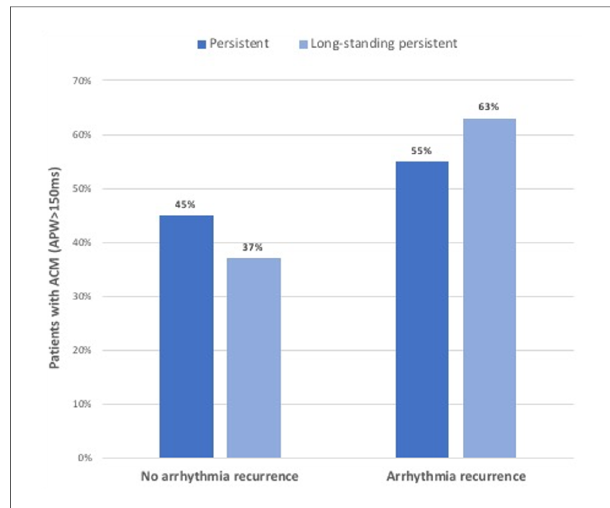
FIGURE 4 Outcomes of cryoballoon pulmonary vein isolation in patients with atrial cardiomyopathy (i.e. APW ≥ 150 ms), strati fi ed by type of atrial fi brillation (persistent vs. long-standing persistent).